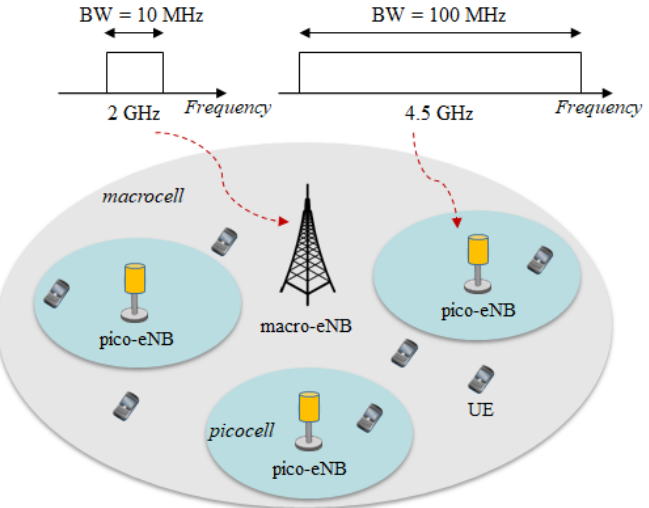
Figure 1. Multiband HetNet combining macrocell operating at 2.0 GHz and picocells with a wide bandwidth operating at 4.5 GHz.